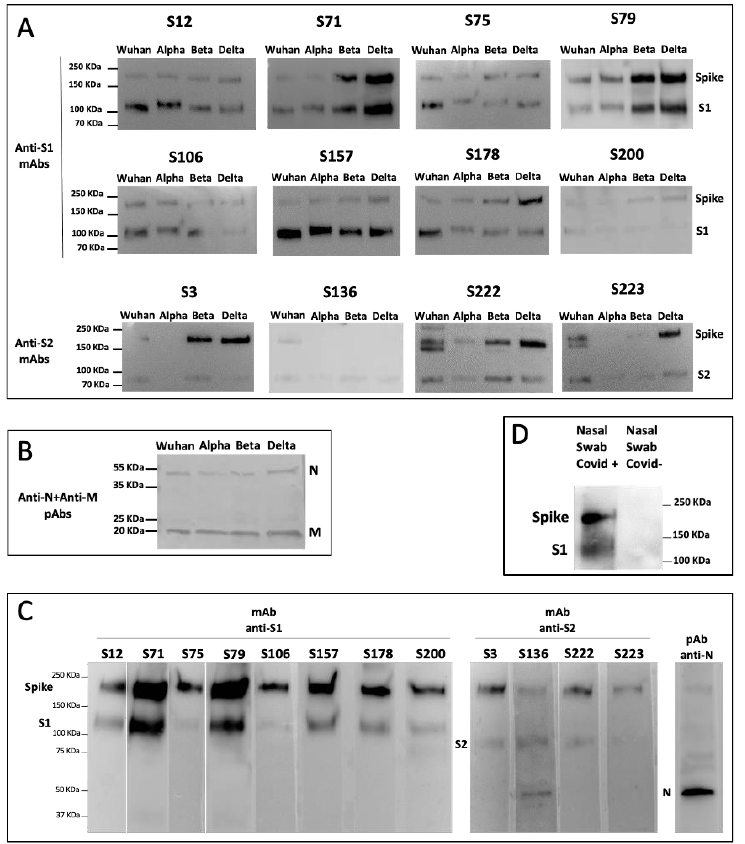
Figure 6. Isolated S-specific mAbs recognize the major SARS-CoV-2 Variants of Concern. ( A ) WB analysis of all of the generated mAbs specific for the S1 and S2 domains in SDS-PAGE supernatants of Vero E6 cells infected with SARS-CoV-2 Wuhan, Alpha, Beta, and Delta VOC. The signal was detected by HRP chemiluminescent substrate except for the S200 and S136 mAbs, which were re- vealed by TMB colorimetric substrate. ( B ) Representative WB of anti-N and anti-M polyclonal Abs (pAbs) detected by colorimetric substrate. ( C ) WB analysis of all of the generated mAbs specific for S1 and S2 proteins in SDS-PAGE supernatants of Vero E6 cells infected with SARS-CoV-2 Omicron VOC. WB of anti-N polyclonal Ab (pAb) was performed as a control on the same strip of S106 mAb. D) WB analysis of a mixture of the two representative mAbs specific for the S1 domain (S71 and S79) in SDS-PAGE nasal swabs from a positive (Covid+) or negative (Covid − ) individual. One ex- periment representative of three is shown. 3.6. The Isolated mAbs Are Useful Tools for an Antigenic Diagnostic Assay: A Preliminary Proof-of-Concept As a preliminary proof-of-concept for the possibility of using the generated mAbs as tools for the antigenic diagnosis of COVID-19 in rapid tests, we performed dot blot and lateral flow assay. SARS-CoV-2 from supernatant of infected Vero E6 cells or lysed nasal swabs from COVID-19-positive patients (whose diagnosis was confirmed by rRT-PCR) and from control healthy subjects were directly coated on membranes and then incubated with mAbs revealed by specific anti-mouse antibodies as described in M&M. All of the mAbs were able to detect the presence of SARS-CoV-2 in both in vitro-produced viral sample, even when highly diluted, and in the biological sample, indicating a good sensi- tivity (Figure 7A). The two most efficient pairs of mAbs (S71-S79 and S71-S12) were